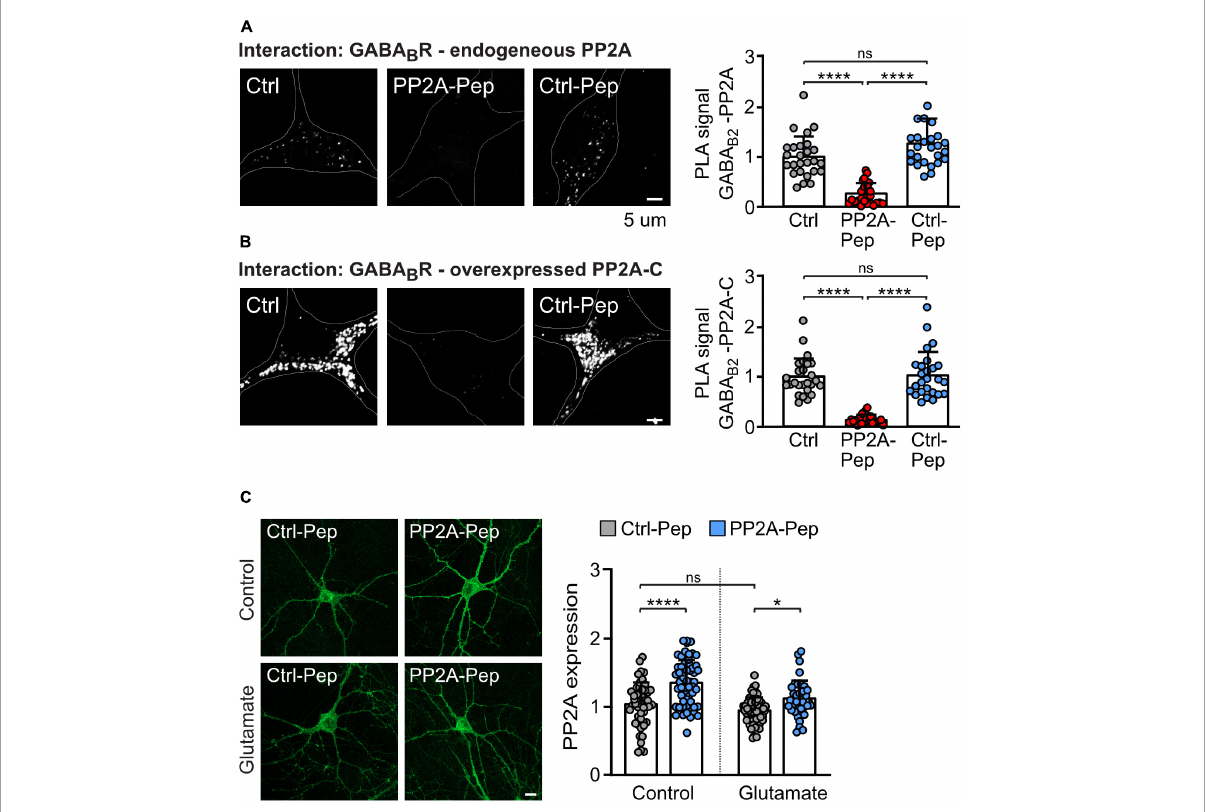
FIGURE3 PP2A-Pep inhibits the interaction of GABA B receptors with PP2A and does not downregulate PP2A expression. (A,B) PP2A-Pep prevents the PP2A/GABA B receptor interaction. (A) The interaction of endogenous PP2A with endogenous total (cell surface and intracellular) GABA B receptors in the presence or absence of PP2A-Pep (10 µ M) was analyzed by in situ PLA using antibodies directed against PP2A and GABA B2 . (B) The interaction of GABA B receptors and the overexpressed catalytic subunit of PP2A (PP2A-C) in the presence or absence of PP2A or Ctrl-Pep was analyzed by in situ PLA. Neurons were co-transfected with EGFP for identification of PP2A-C overexpressing neurons. Neurons transfected only with EGFP and not treated with peptides served as controls. Left: representative images (white dots represent interactions, scale bar: 5 µ m). Right: quantification of the in situ PLA signals. The data were normalized to control cultures not treated with peptides and represent the mean ± SD of 26 neurons derived from three independent experiments. Brown–Forsythe and Welch ANOVA with Games Howell’s multiple comparison test (ns, p > 0.05, * p < 0.05, **** p > 0.0001). (C) PP2A-Pep does not downregulate PP2A expression. Glutamate-stressed and unstressed neurons were treated with PP2A-Pep (10 µ M) and analyzed for PP2A expression. Left: representative images (scale bar: 10 µ m). Right: quantification of the immunofluorescence. The data were normalized to control cultures not treated with glutamate and peptide and represent the mean ± SD of 38–60 neurons derived from three independent experiments. Two-way ANOVA followed by Tukey’s multiple comparison test (ns, p > 0.05; * p < 0.05, **** p <